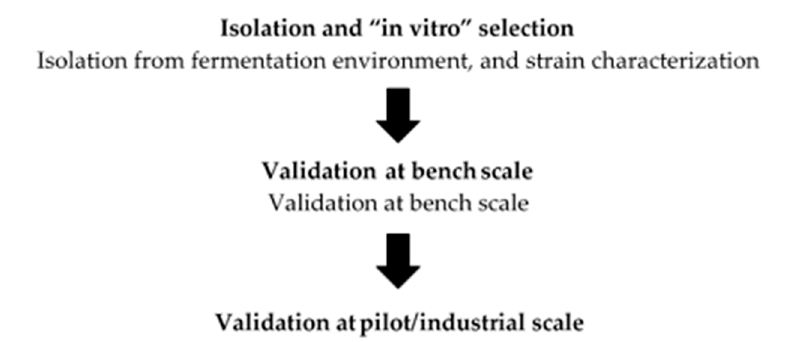
Figure 10. Major steps underlying the selection of starter cultures.